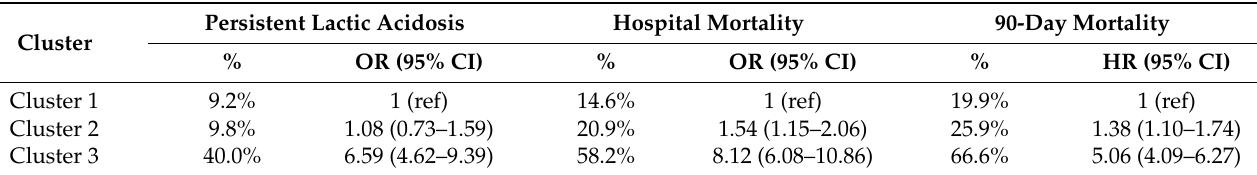
Table 2. Outcomes according to clusters of lactic acidosis.